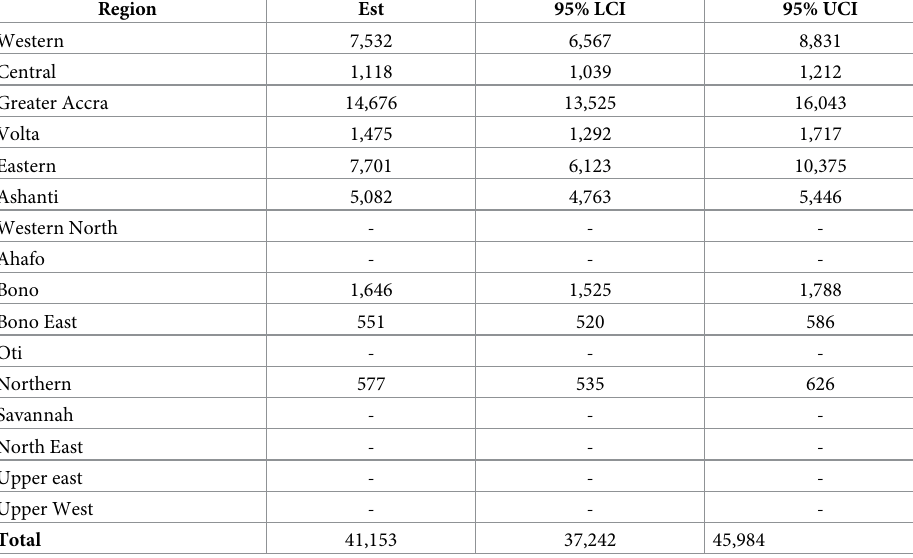
Overall comparison of estimates according to the method used Presented in Table 4 are the size estimates of the female sex workers in Ghana using the three population size estimation and the census methods. These include the Census and Enumera- tion method (seaters), the Capture-Recapture (roamers), Service Multiplier (both seaters and Table 3. Population size of roamer FSW using service multiplier by region in Ghana, 2020.